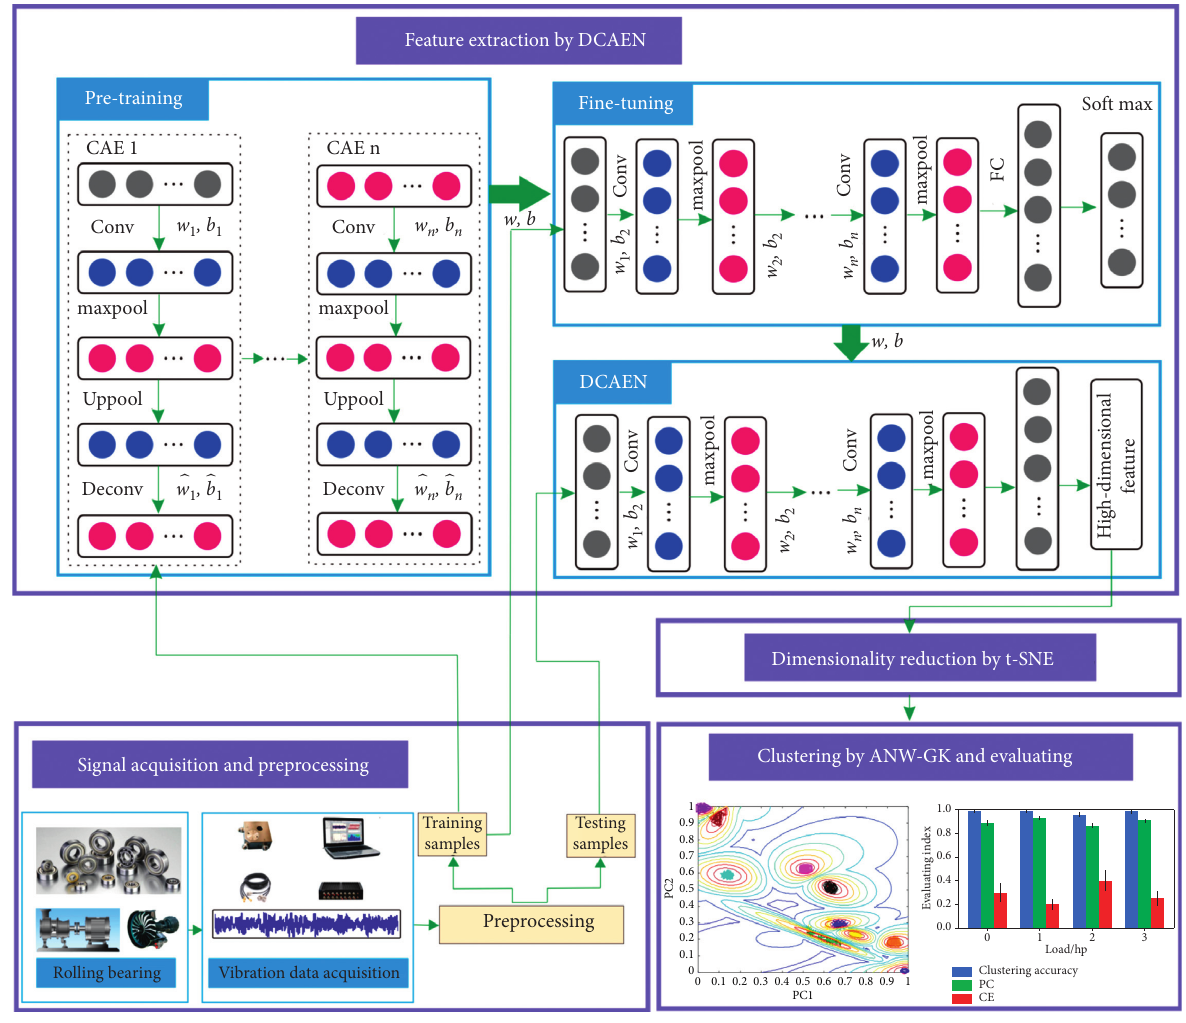
Figure 4: The framework of the proposed method.